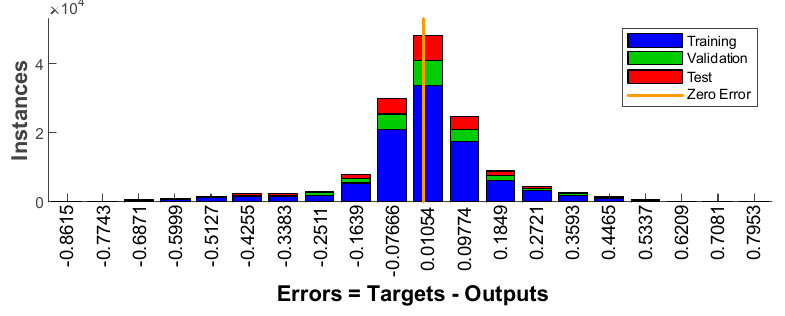
Figure 11. MSE histogram with 20 bins.